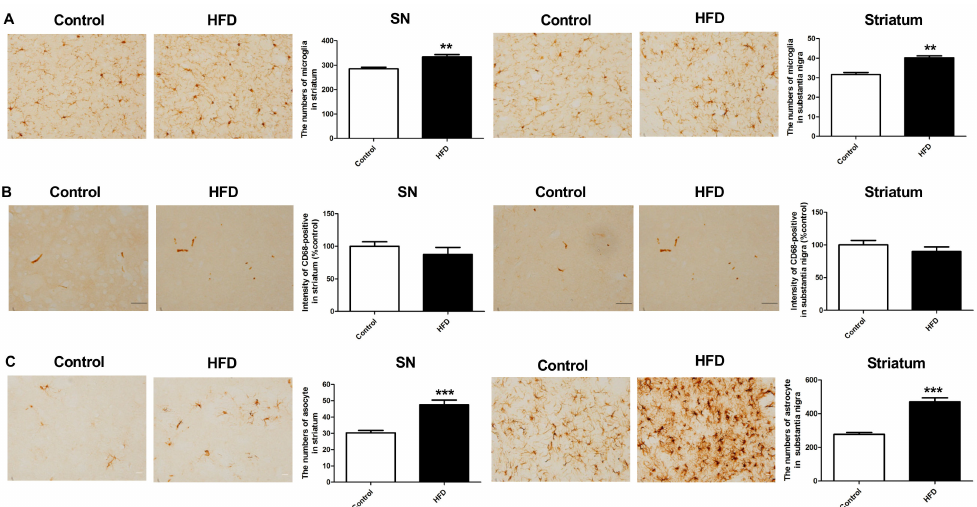
Figure 5. Immunostaining for astrogliosis in the SN and striatum. ( A ) We stained the microglia for Iba-1, which showed an increased number of microglia in the SN and striatum of HFD mice. ( B ) CD68 immunostaining of microglia did not show di ff erence between HFD and control groups. ( C ) GFAP staining of astrocytes showed a significant increase in the number of GFAP-positive cells in the SN and striatum in the HFD mice compared to that in the controls. Therefore, the HFD caused increased astrogliosis in the SN and striatum. Scale bar = 100 µ m. The asterisks represent the level of statistical significance calculated using a two-tailed Student’s t -test (** p < 0.01, *** p < 0.001); data are represented as mean ± SEM ( n = 10 in each group). Iba-1: ionized calcium-binding adaptor molecule 1; GFAP: glial fibrillary acidic